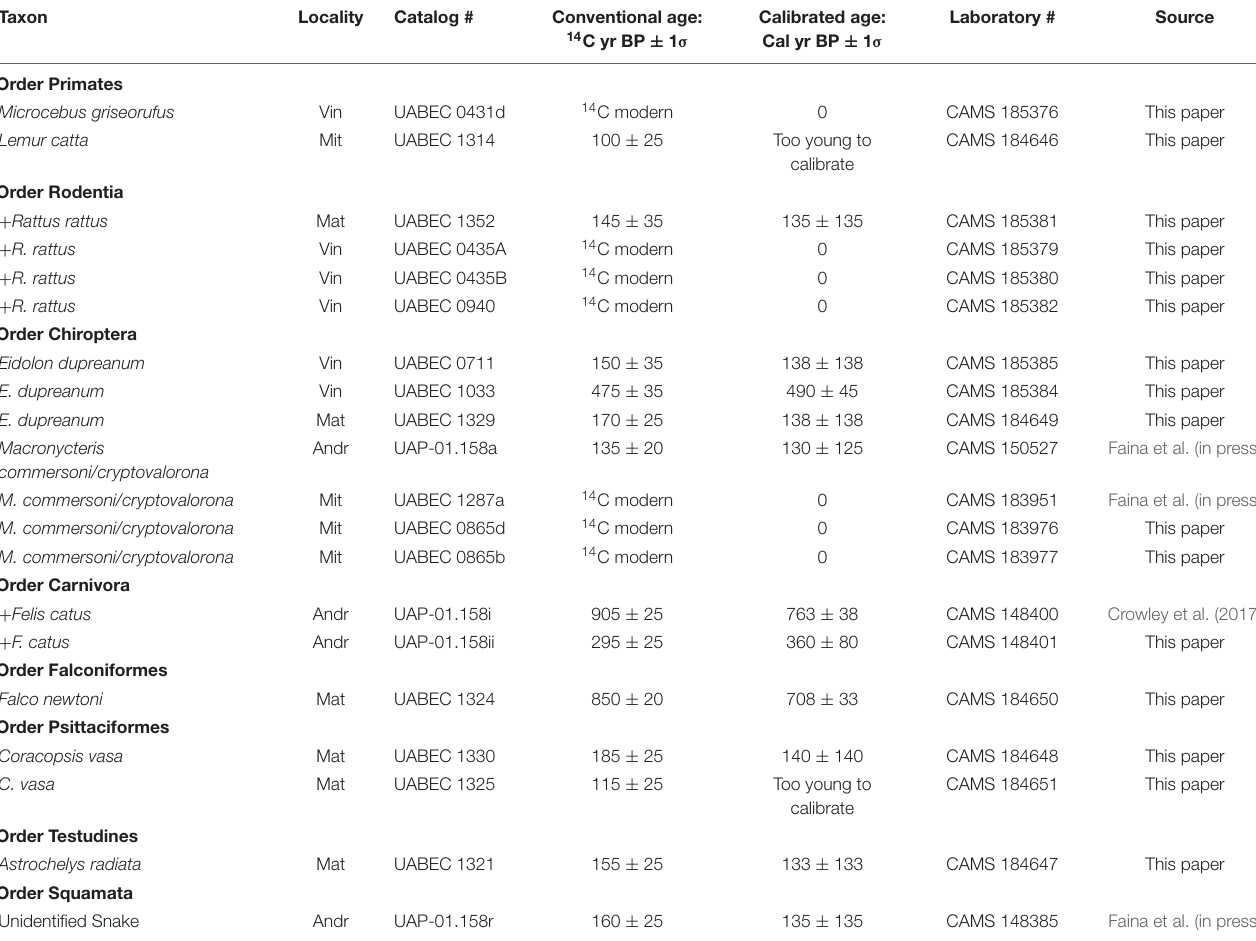
TABLE 4 | Tsimanampesotse/Antsirafaly specimens with conventional and calibrated 14 C dates younger than 900 yr BP.